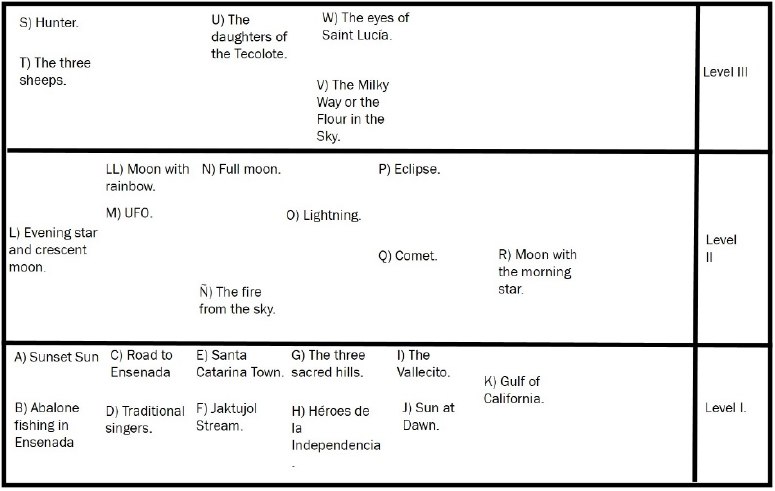
Figure 2. Pa Ipai sky cybercartographic atlas.